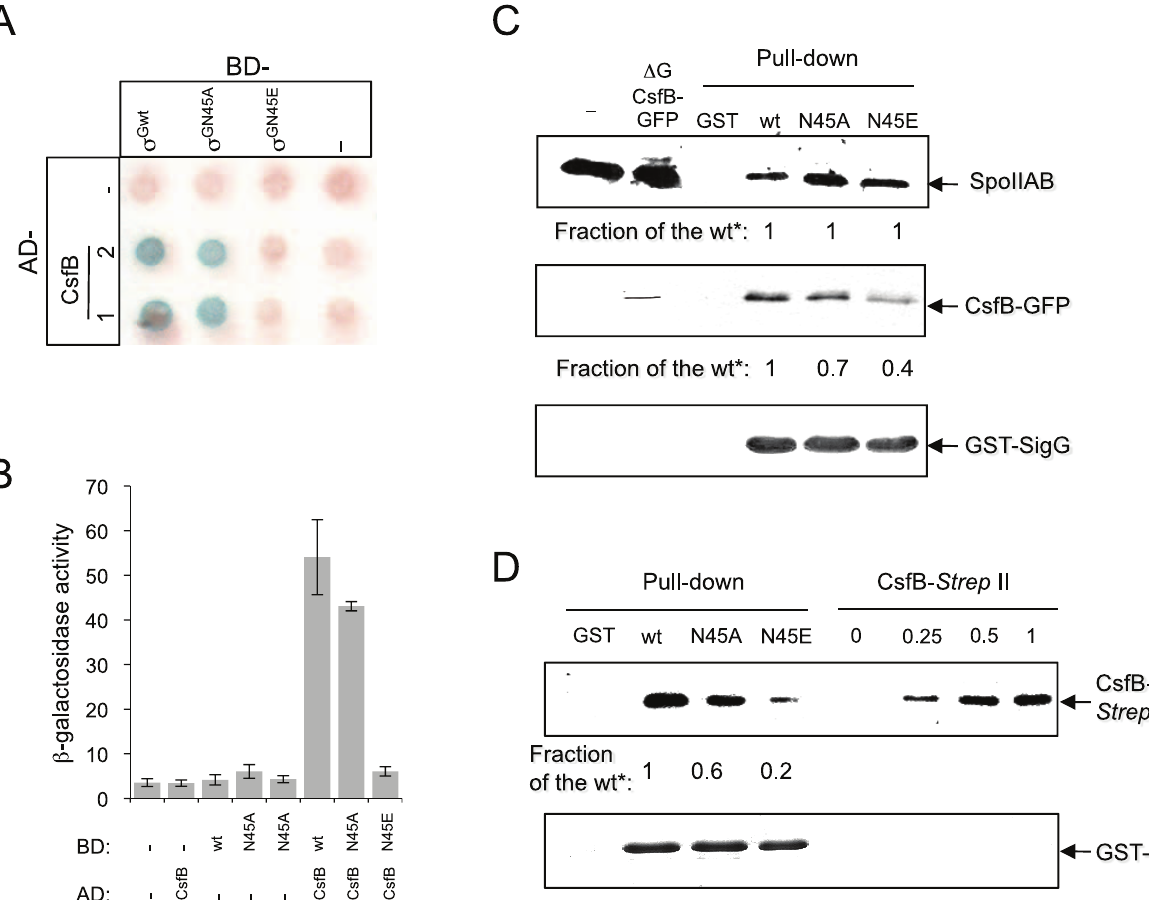
Figure 4. Interactions of SpoIIAB and CsfB with s G , s GN45A , and s GN45E . Panels A and B: colony lift (A) and quantitative assay on liquid medium (B) for the detection of b -galactosidase activity in yeast strains expressing fusions of CsfB to the GAL4 activation domain (AD; two colonies are shown) and fusions of s G , s GN45A or s GN45E to the GAL4 binding domain (BD), as indicated. Assays in which the BD and AD were expressed from empty vectors were used as negative controls (‘‘ 2 ’’). b -galactosidase activity was detected with X-Gal after a reaction time of 30 min (A), or with the ONPG substrate (B) and expressed in Miller units. The data represented in panel B are the average of three independent experiments. Panel C shows the results of pull-down with GST (lane GST), GST- s G , GST- s GN45A , or GST- s GN45E fusion proteins (as indicated above the panel) immobilized on glutathione agarose beads. Cell extracts from a B. subtilis strain producing a CsfB-GFP fusion were prepared from DSM cultures 2 hours into stationary phase, and incubated with the various beads preparations. Bound proteins were visualized, following elution, by immunoblotting with anti-SpoIIAB and anti-GFP antibodies. The extract used in the assay ( D G CsfB-GFP) as well as an extract prepared from the wild type MB24 strain (control for the GFP antibody) at hour 2 of sporulation in DSM, were also directly loaded on the same gel. Panel D: GST pull-down assays with purified CsfB- Strep II tag. GST and the various GST- s G fusions (wt, N45A, and N45E, as indicated) were bound to glutathione beads and incubated with purified CsfB- Strep II (100 nM). Bound proteins were detected, following elution, with an anti- Strep II tag antibody. In the lanes denoted ‘‘CsfB- Strep II’’ the indicated amounts of purified protein (in ng) were analyzed by immunoblot as a control for the intensity of the signal in the pull-down experiments. In panels C and D, ‘‘Fraction of the wt*’’ refers to the binding ratio between of GST- s G , GST- s GN45A , or GST- s GN45E to SpoIIAB or to CsfB (C), or CsfB- strep II tag (D). The numbers were determined through densitometric analysis of the blots, and are averages of three independent experiments.